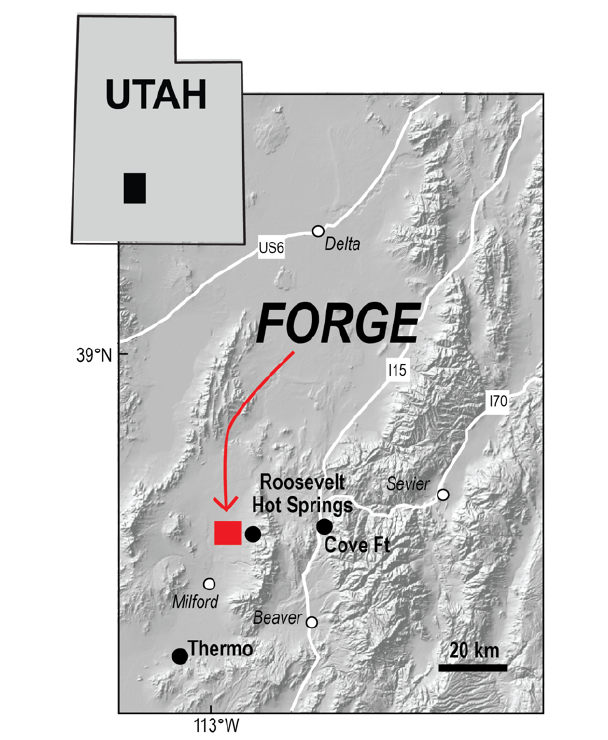
Figure 1. Location of FORGE site near Milford, Utah, USA.